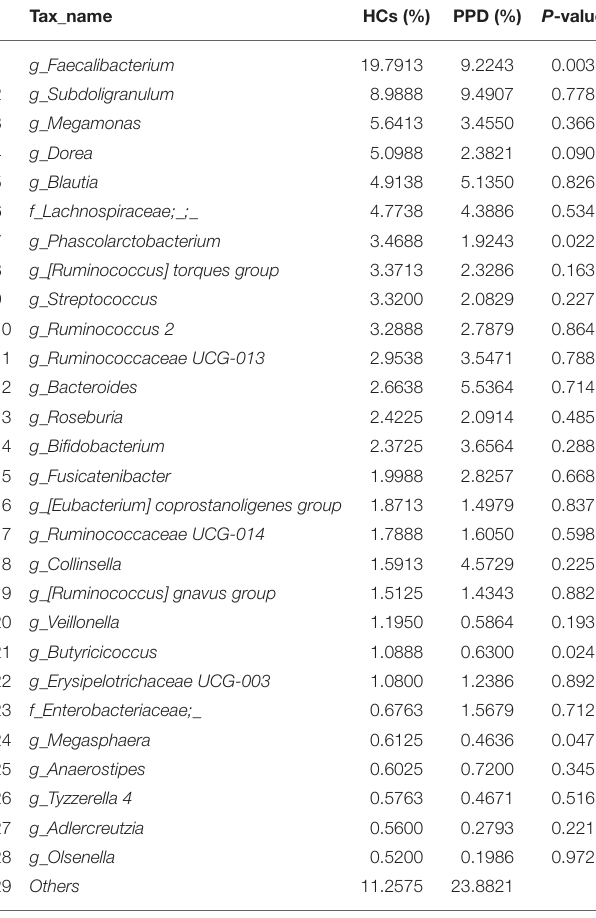
TABLE 3 | Relative abundance of gut microbial communities at the genus